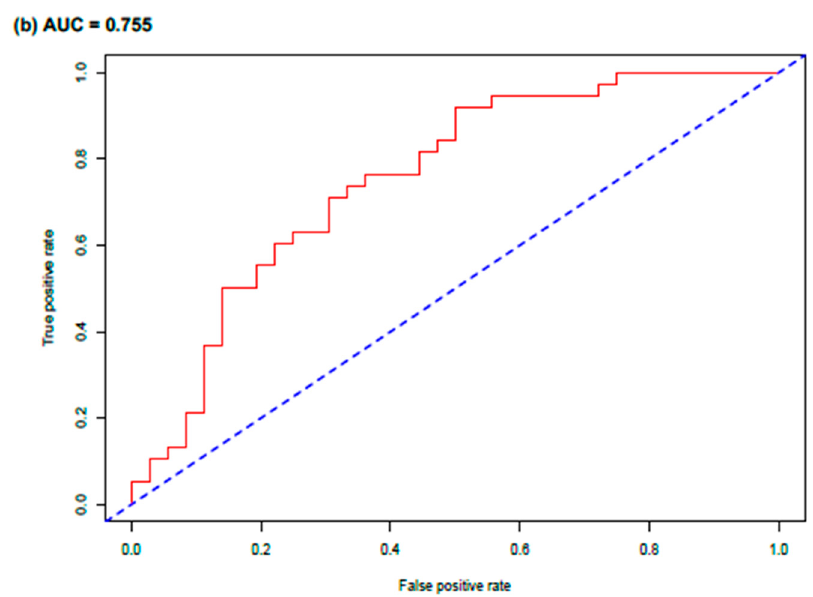
Figure 3. ( a ) Random Forest Analysis (RFA) and ( b ) Receiver Operating Characteristic (ROC) investigations on the prediction of Weighted Standing Time (WST) classes 0 versus 1, and the relative importance of activin B and pathology markers in separating the two WST classes of ME / CFS severity. AUC—area under curve (accuracy calculation from true and false positive rates).